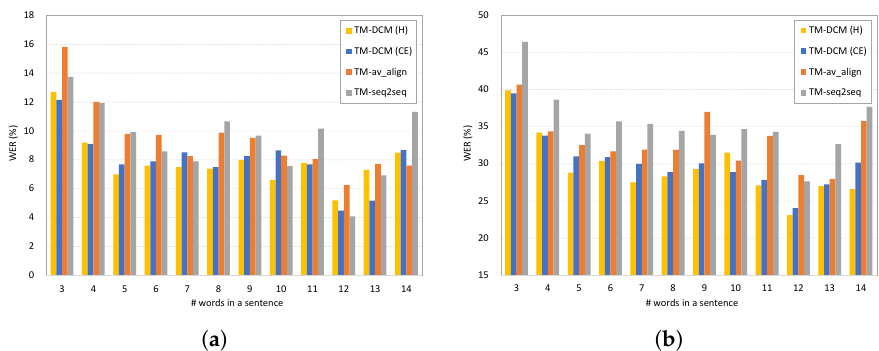
Figure 8. WERs according to the numbers of words in sentences for the models using audio–visual modality on the test sets of LRS2-BBC and LRS3-TED datasets with ( a ) clean and ( b ) noisy reverberant audio data.